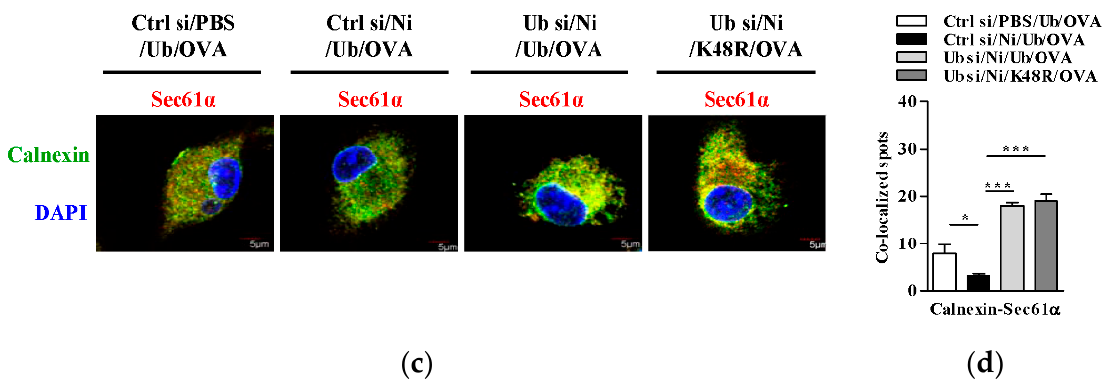
Figure 6. K48-linked ubiquitination contributes to nicotine-increased endosomal relocation of Sec61 α in dendritic cells. ( a , b ) Murine ubiquitin-deficient and control BM-DC were stimulated with nicotine (10 − 7 mol/L) for 12 ~ 16 h. Then, the cells were replenished with K48R-Ub or WT-Ub (30 × 10 − 6 mol/L) and further incubated with ovalbumin (50 µ g/mL) for 5~6 h. The endosomal relocation of Sec61 α ( a ) from the endoplasmic reticulum ( b ) was determined by confocal microscope with EEA1, calnexin, and Sec61 α antibody staining. EEA1 ( a ), calnexin ( b ) were stained green; Sec61 α was stained red; nuclei were counterstained with DAPI (blue). The co-localized spots of Sec61 α with EEA1 ( c ), Sec61 α with calnexin ( d ) were counted and analyzed. Data are presented as the mean ± SEM, * p < 0.05, *** p < 0.001, one-way ANOVA with Newman-Keulspost test. One representative from three independent experiments is shown. EEA1: early endosome marker; Calnexin: endoplasmic reticulum marker; Ni: nicotine; Ub: ubiquitin; si: siRNA; OVA: ovalbumin.